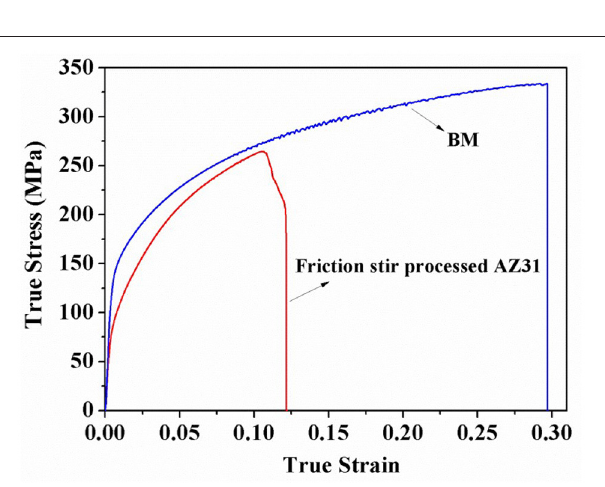
FIGURE 3 | Stress-strain curves of the transverse tensile specimen cut from the BM and the FSP AZ31Mg alloy (Xin et al., 2012) (Copyright © 2012, Springer